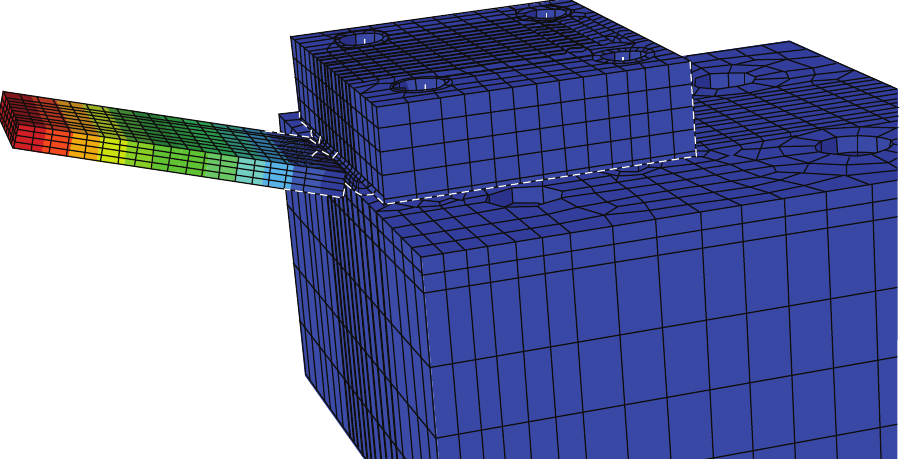
Figure 12: First mode for crack extension, 𝑎 = 0.000 in.